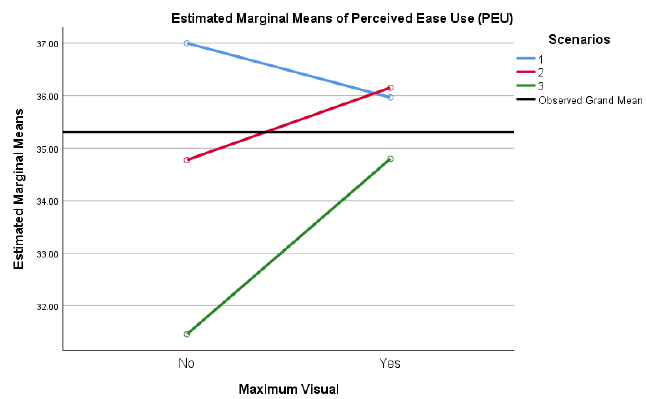
Figure 7. Estimated marginal means—perceived ease use (PEU).